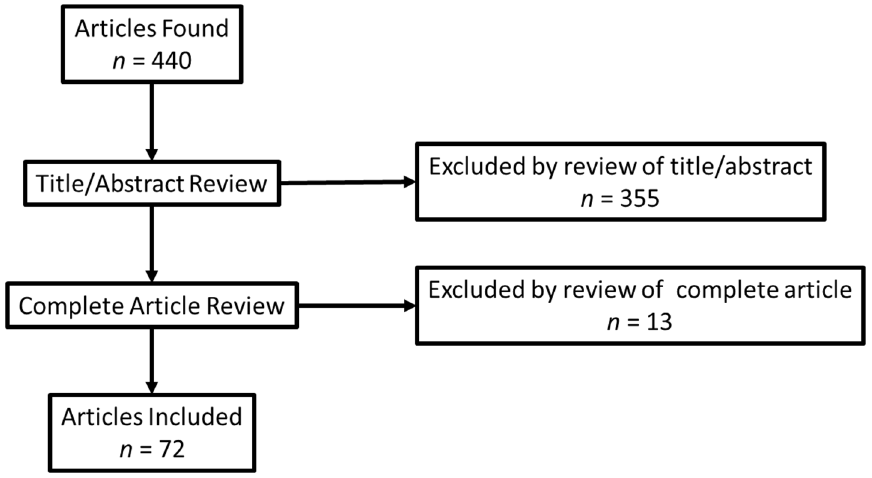
Figure 1. Prisma